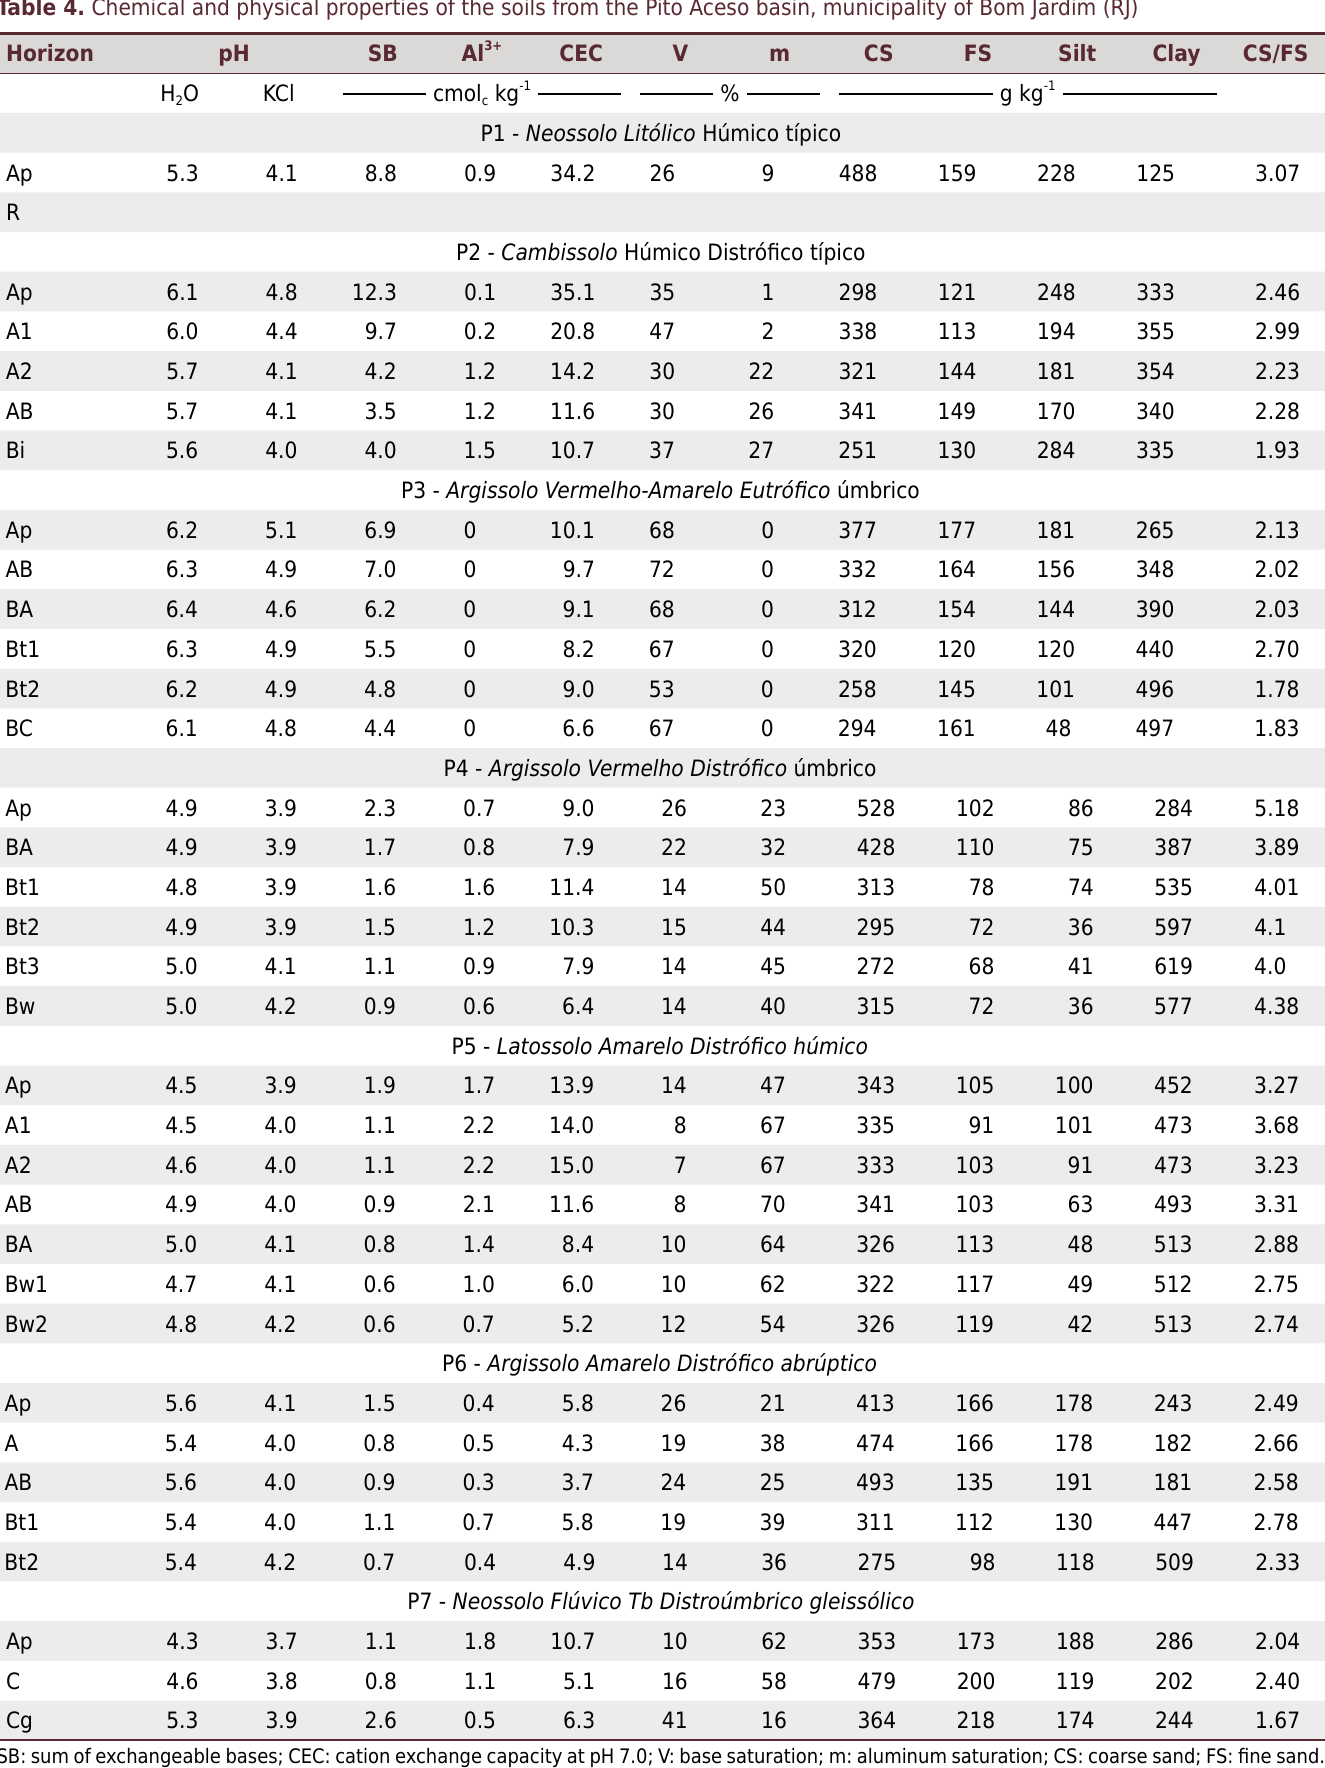
Table 4. Chemical and physical properties of the soils from the Pito Aceso basin, municipality of Bom Jardim (RJ) Horizon pH SB Al